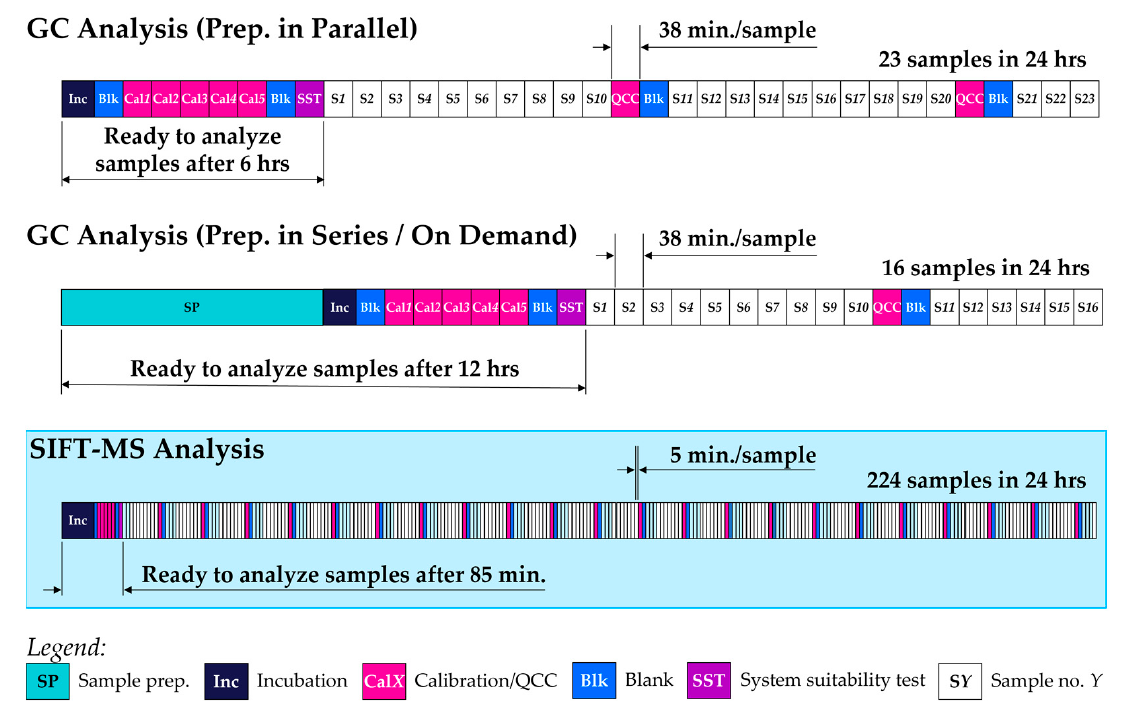
Figure 6. Headspace SIFT-MS enables analysis of ethylene oxide in Polysorbate 80 samples to be conducted at significantly higher throughput, while eliminating very slow sample preparation, due to enhanced sensitivity. Used with permission of Syft Technologies.